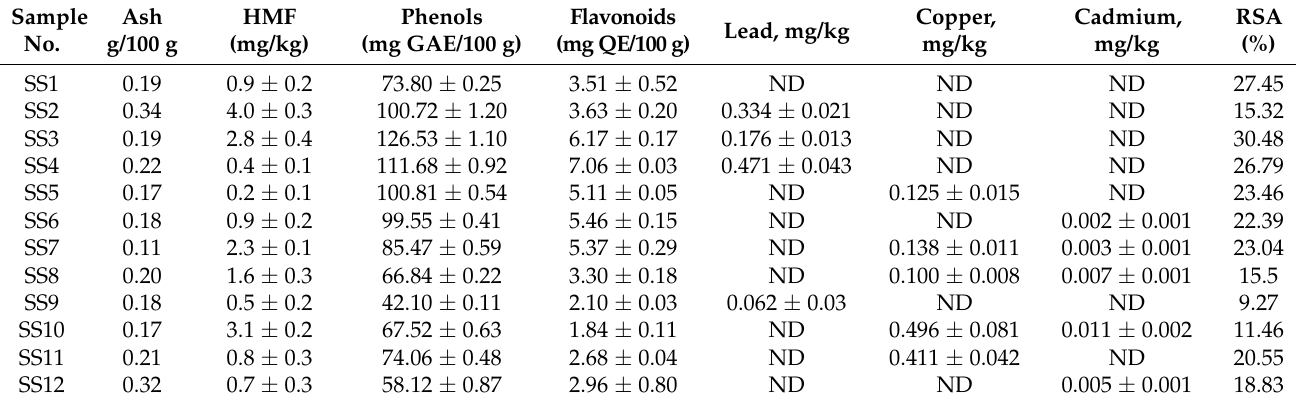
Table 4. The chemical parameters of the honey samples from Alba